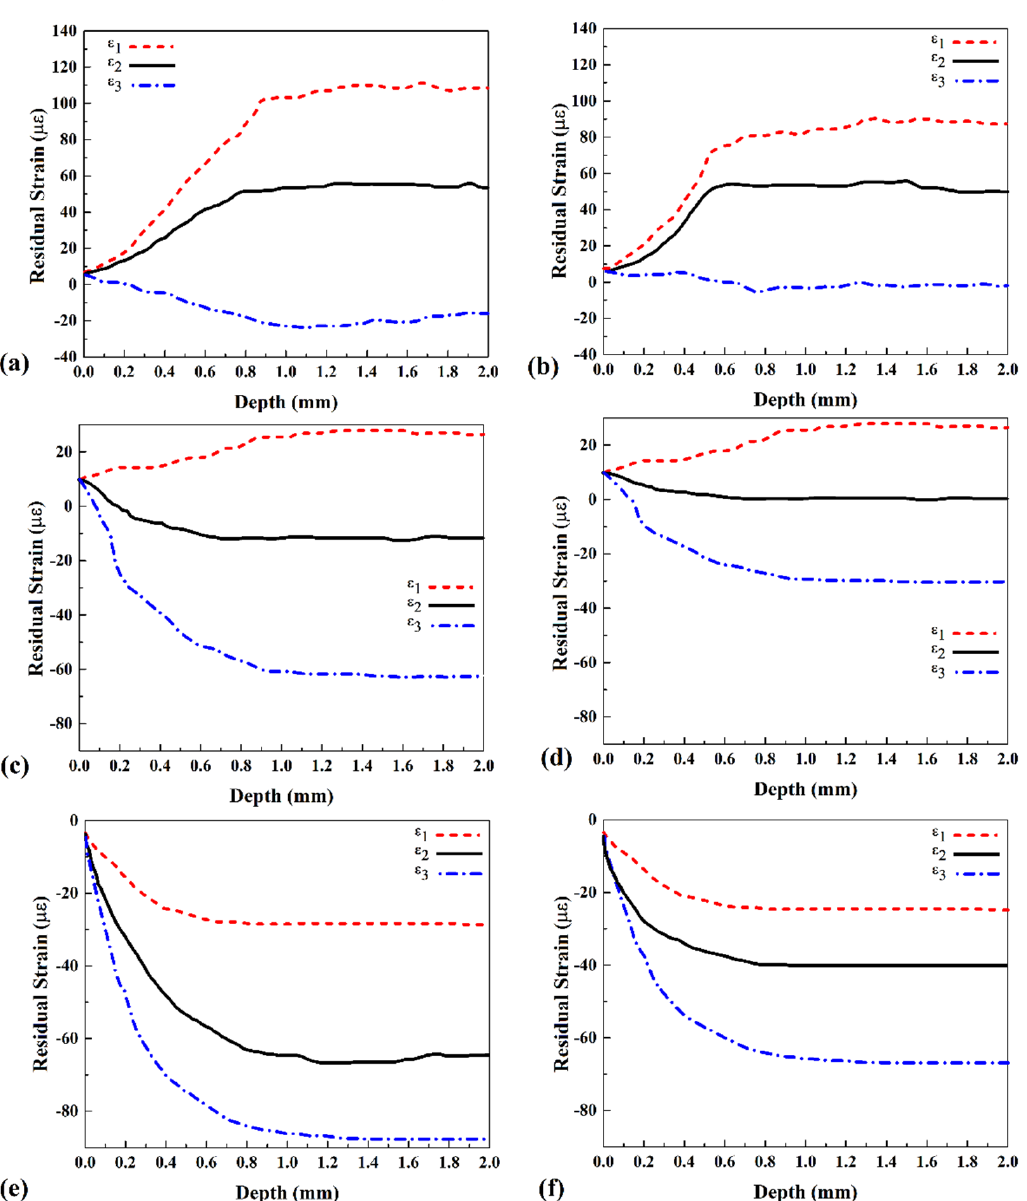
Figure 7. Measured residual strain in the FSW sample by ( a ) rosette (I), ( c ) rosette (II), and ( e ) rosette (III). Measured residual strain in the UFSW sample by ( b ) rosette (I), ( d ) rosette (II), and ( f ) rosette (III). The ε 1 at 15 mm and 30 mm from the joint line in the FSW sample were 30 µε and − 28 µε , while the ε 1 at 15 mm and 30 mm from the joint line in the UFSW sample were 25 µε and − 22 µε , respectively. The minus sign of residual strain shows that the strain in the joint line is stretching, and with increasing from the joint line, it became compression. The